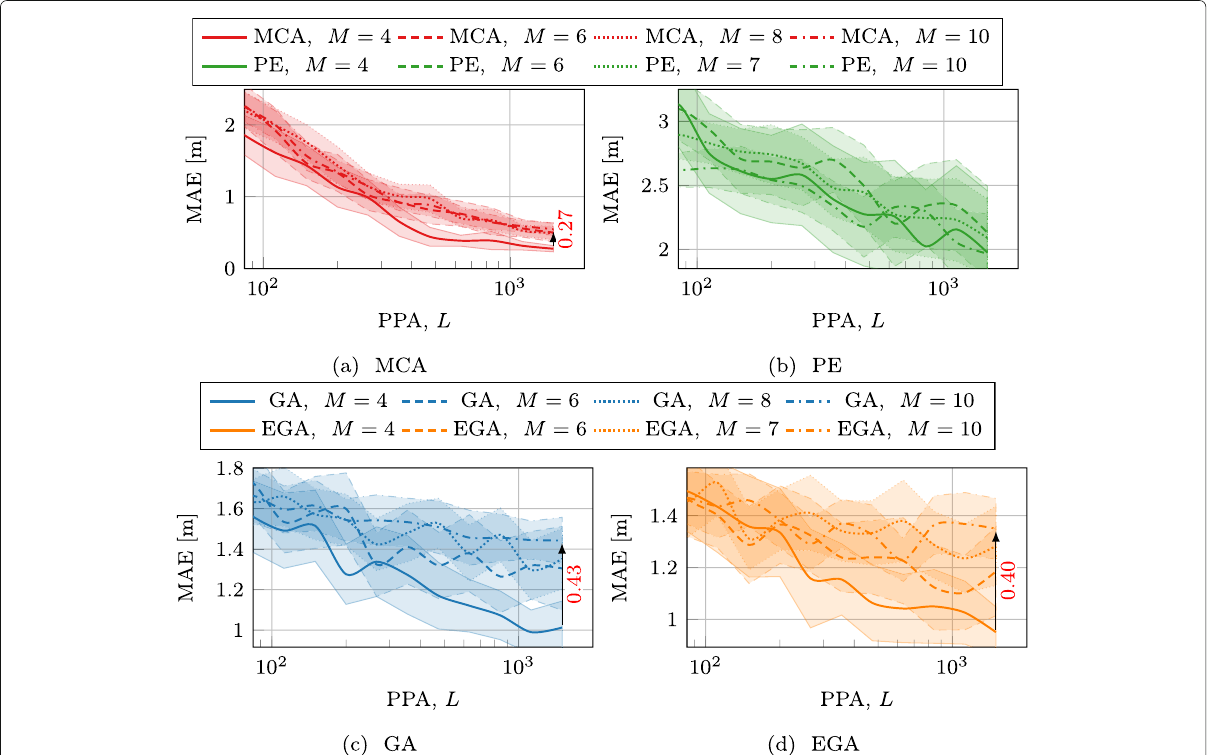
Fig. 12 Localization performance as a function of the PPA value and as a function of the number of agents to be tracked. a MCA. b PE. c GA. d EGA